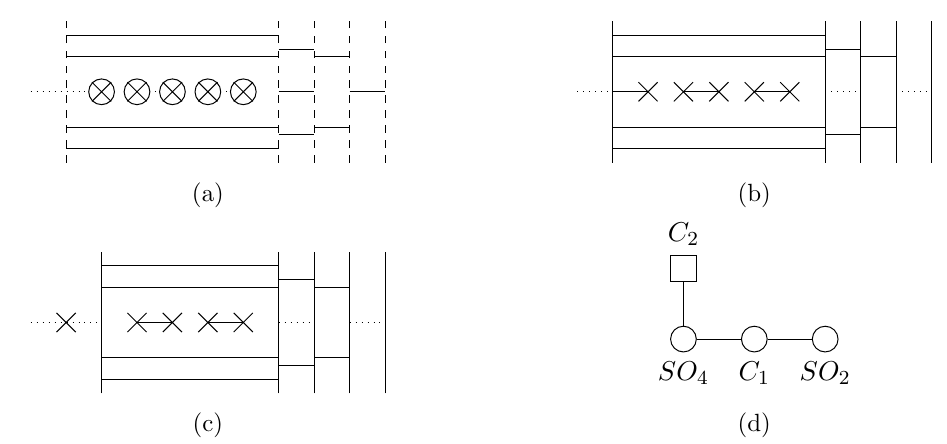
Figure 29. Result of S-duality on the model with n s = n d = 5, ~l d = (4 ; 4 ; 4 ; 4 ; 4), ~l s = (0 ; 2 ; 0 ; 2 ; 0) and rightmost orientifold plane O 3 (cid:0) . (a) Higgs branch of the initial model. (b) Resulting model after performing S-duality on (a). (c) Resulting model after performing the collapse transition (i.e. pull all half D5-branes away from O 3 (cid:0) planes without brane creation) on (b), this is necessary to read the quiver. (d) Quiver obtained from (c) with the choice of SO 4 and SO 2 as gauge nodes. (cid:26) so (5), [42]. This choice is necessary to obtain a Coulomb branch M C = (cid:22) O (5)